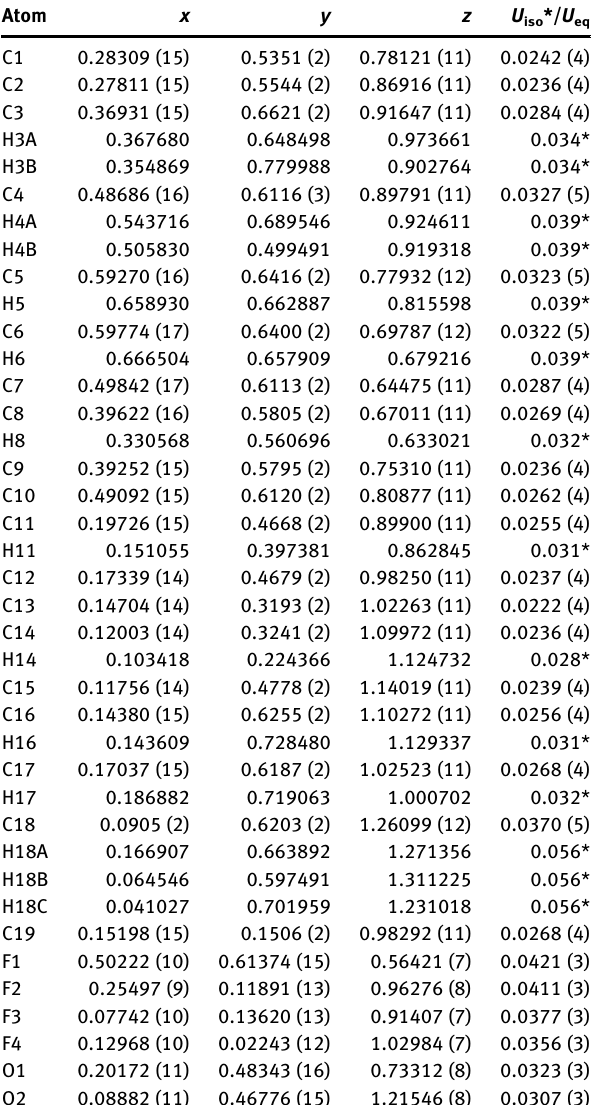
stage, and studied their anti-neuroin fl ammatory activity. The results showed that the fl uorine-substituted com- pounds had better activity [8 – 10]. In this study, a new